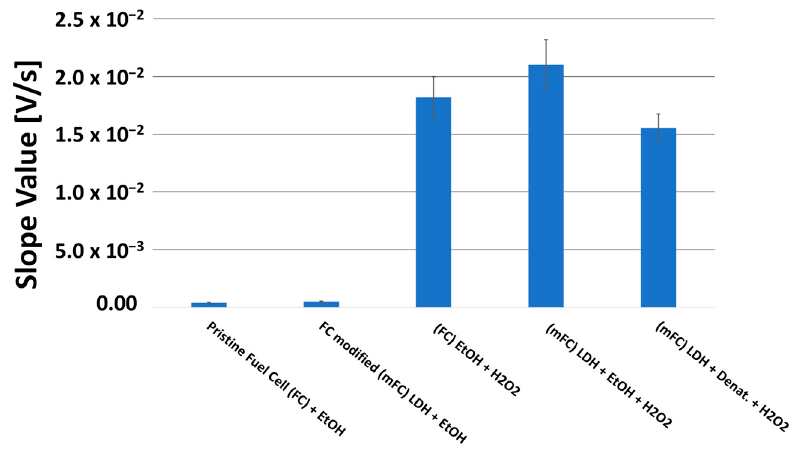
Figure 9. Comparison by bar chart diagram of the slope values of the tangent line at the point of maximum slope to the voltage–charge curves, obtained by fuel cell, fed with ethanol solution: pris- tine, modi fi ed with LDHs, pristine with H 2 O 2 in solution (12 mmol L − 1 ), modi fi ed with LDHs and H 2 O 2 in solution (12 mmol L − 1 ), and modi fi ed with LDHs and H 2 O 2 in solution (12 mmol L − 1 ), but fed with denatured ethanol (90% by volume) instead of 99.9% by volume of ethanol.